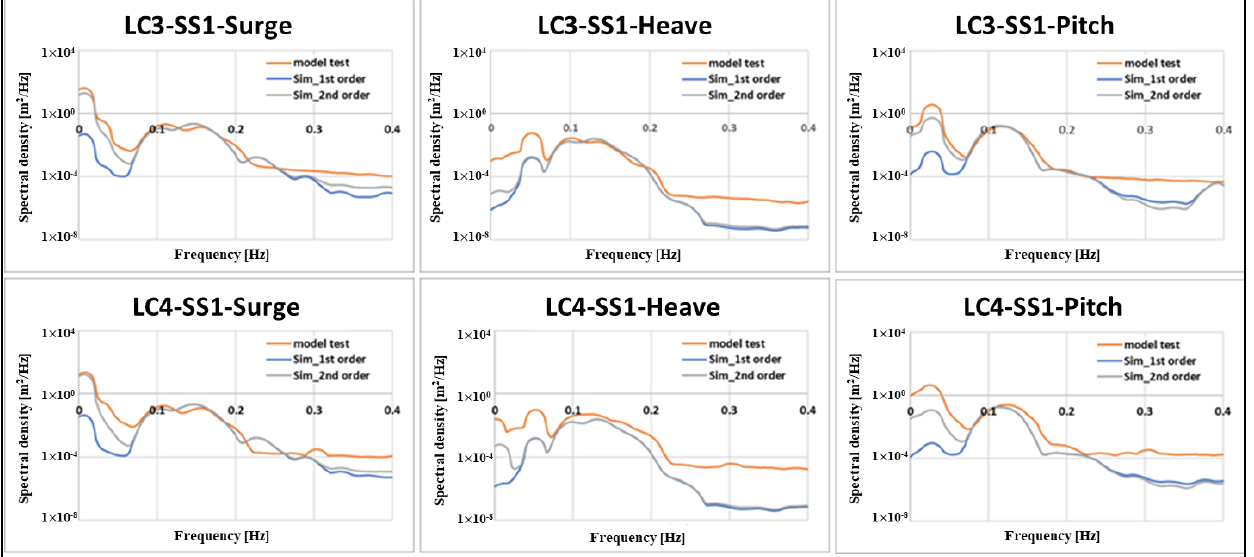
Figure 13. Sea state1: LC3 and LC4 result under irregular waves.